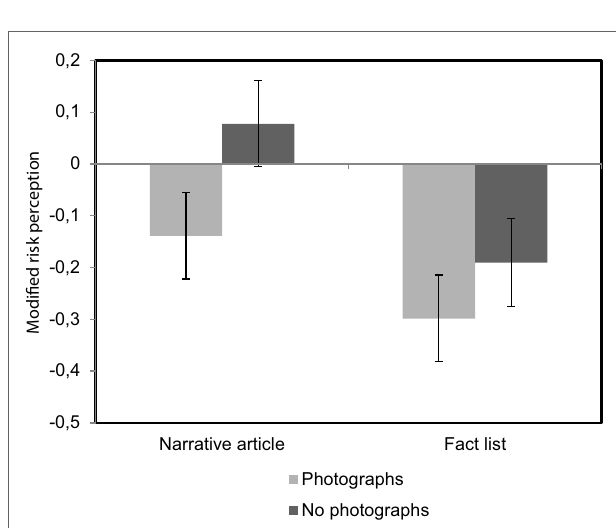
FigUre 3 | Main effect of text type (narrative article vs. fact list) and main effect of visualization (photographs vs. no photographs) on modified risk perception as the difference between risk perception in the posttest and risk perception in the pretest. Error bars represent